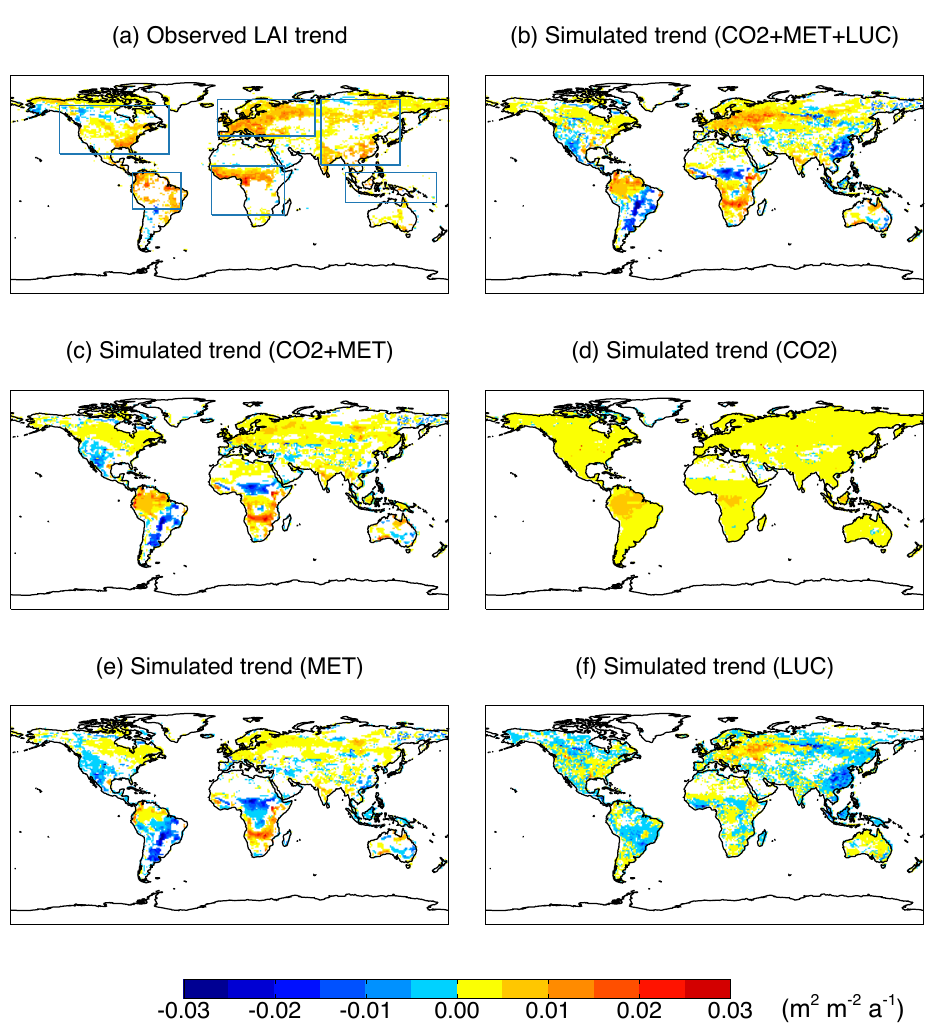
Figure 1. Comparison of trends in (b–f) simulated leaf area index (LAI) with (a) observations for 1982–2011. Observations are derived from GIMMS NDVI. Simulations are performed with either (d, e, f) single forcings or (b, c) the combinations of these forcings. Forcings considered include meteorology from WFDEI reanalysis (MET), CO 2 fertilization (CO 2 ), and land use change (LUC). For every forcing included in the simulation, the year-to-year fields are utilized. Otherwise, the forcing is prescribed at the year 1980. Only significant trends ( p < 0 . 05) are presented. The six box regions in (a) indicate areas for statistical analyses in Table 2.